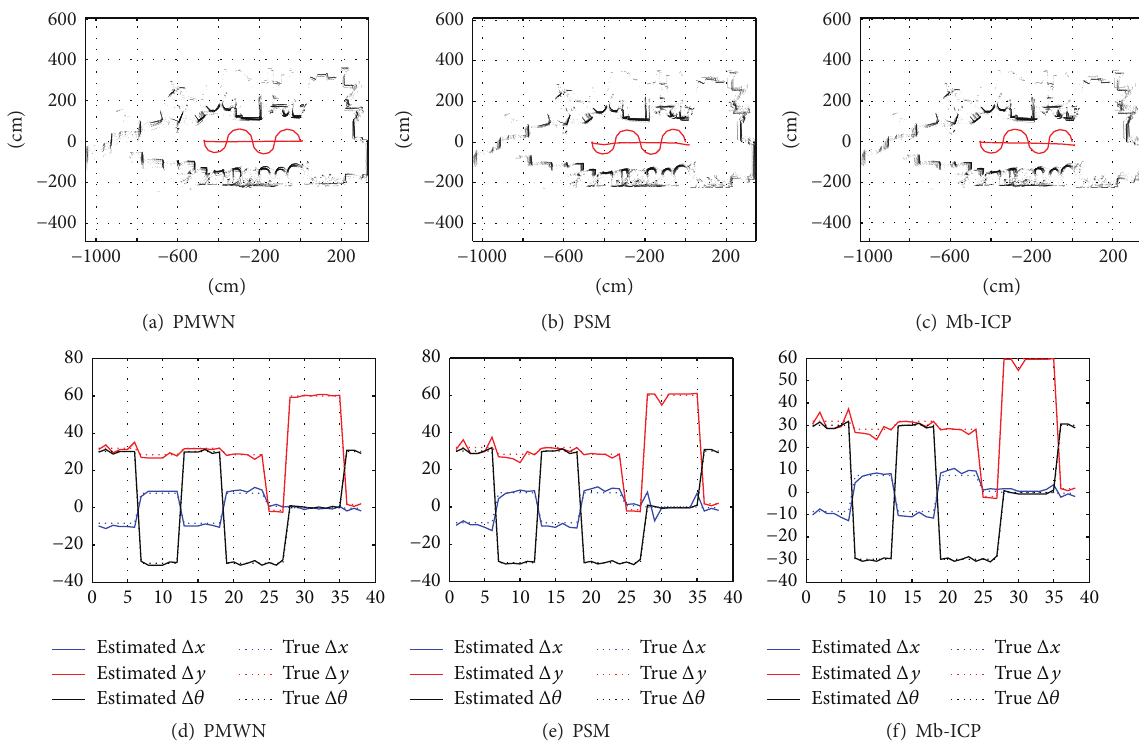
Figure 19: Experiment in laboratory using Series 2 path. ((a), (b), and (c)) The laser sensor is continually placed on footprints of Serial 2 path using PMWN, PSM, and Mb-ICP to map the laboratory. ((d), (e), and (f)) Compare the pose estimation of PMWN, PSM, and Mb-ICP, respectively, with the true pose in Series 2 path in the laboratory.